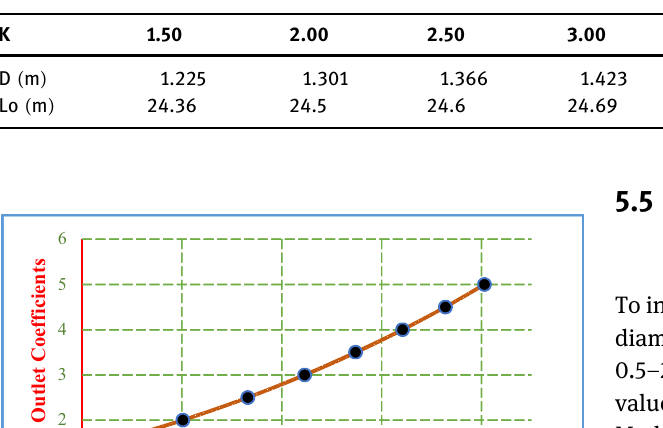
Table 5: Value of optimum diameter and optimum span length vs inlet and outlet coe ffi cients